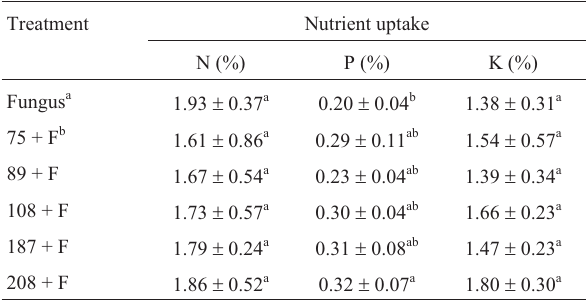
Table 5 - The effect of the inoculation of native PGPR plus the pathogenic fungus on the uptake of N, P and K by apple seedlings in the greenhouse assay.